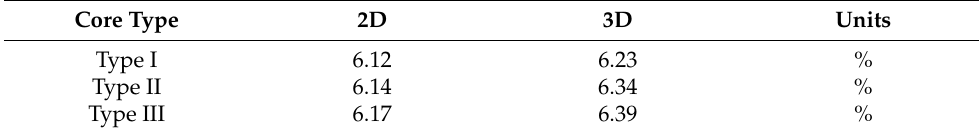
Table 4. Average voltage regulation of the three proposed rotary transformer